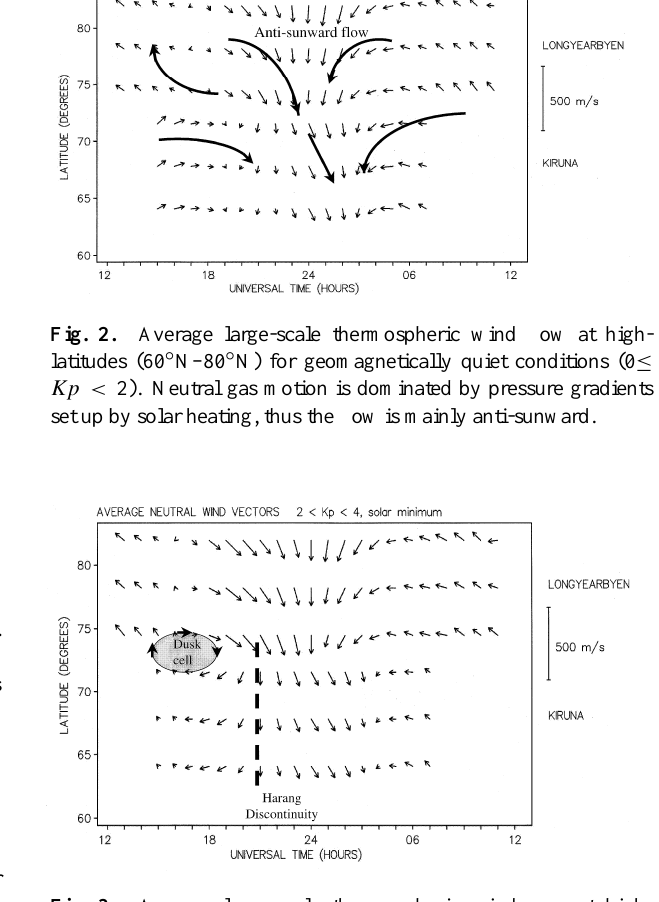
Fig. 3. Average large-scale thermospheric wind flow at high- latitudes (60 ◦ –80 ◦ N) for moderately active geomagnetic conditions (2 ≤ Kp < 5). The modifying influence of the plasma is appar- ent in several respects. A clockwise cell corresponding to the dusk cell of the high-latitude electric field can be seen, centred at about 1600UT and between 70 ◦ –75 ◦ N. Between 56 ◦ –70 ◦ N the flow is westward before 2100UT and eastward afterwards. The Harang Discontinuity is fairly distinct. There is little evidence of the dawn